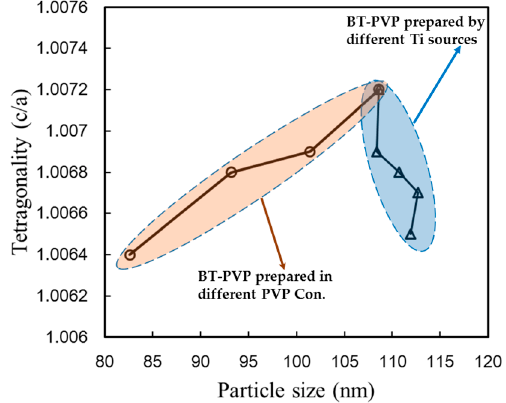
Figure 6. Relation of the tetragonality, c/a, and the particle size of BT-PVP nanoparticles with the process variables of the PVP concentration and Ti source. The blue- and orange-colored regions contain the plotted data of BT-PVP particle sizes obtained from Figures 1 and 5, respectively.